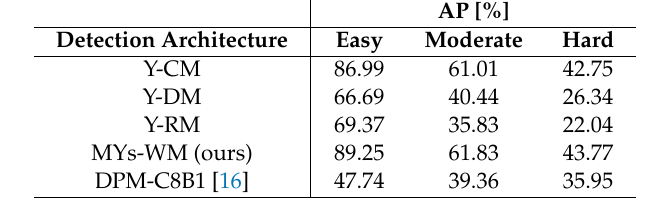
Table 4. Comparison of detection results of pedestrians classified by di ffi culty.